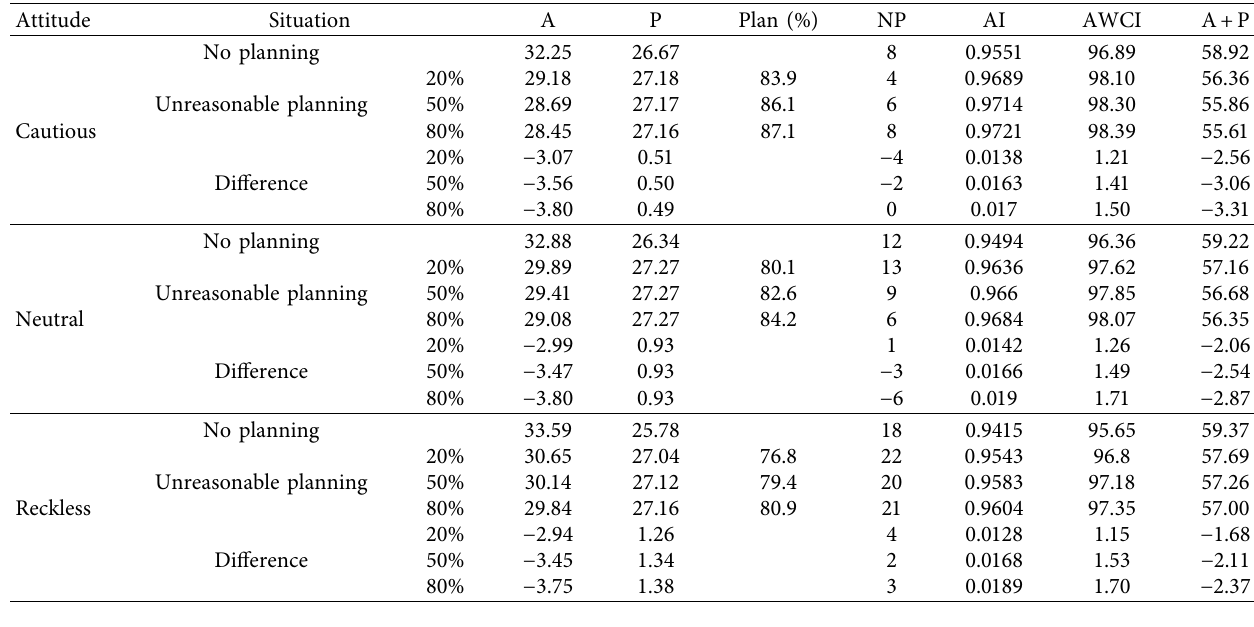
Table 4: Comparison between results of urban development in unreasonable planning scenario and no-planning scenario.